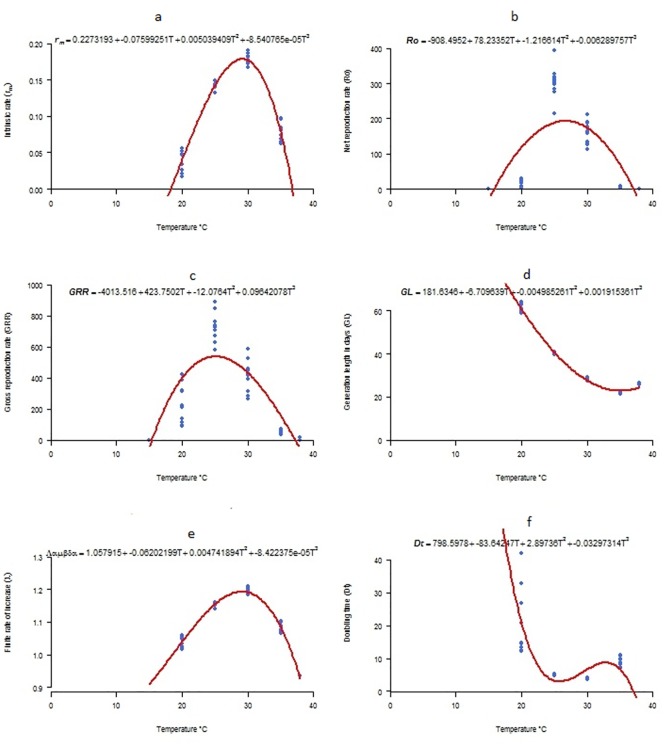
Life table parameters of S. litura estimated at six constant temperatures.Intrinsic rate of natural increase (a), Net reproduction rate (b), Gross reproductive rate (c), Mean generation time (d), Finite rate of increase (e), and Doubling time (f).